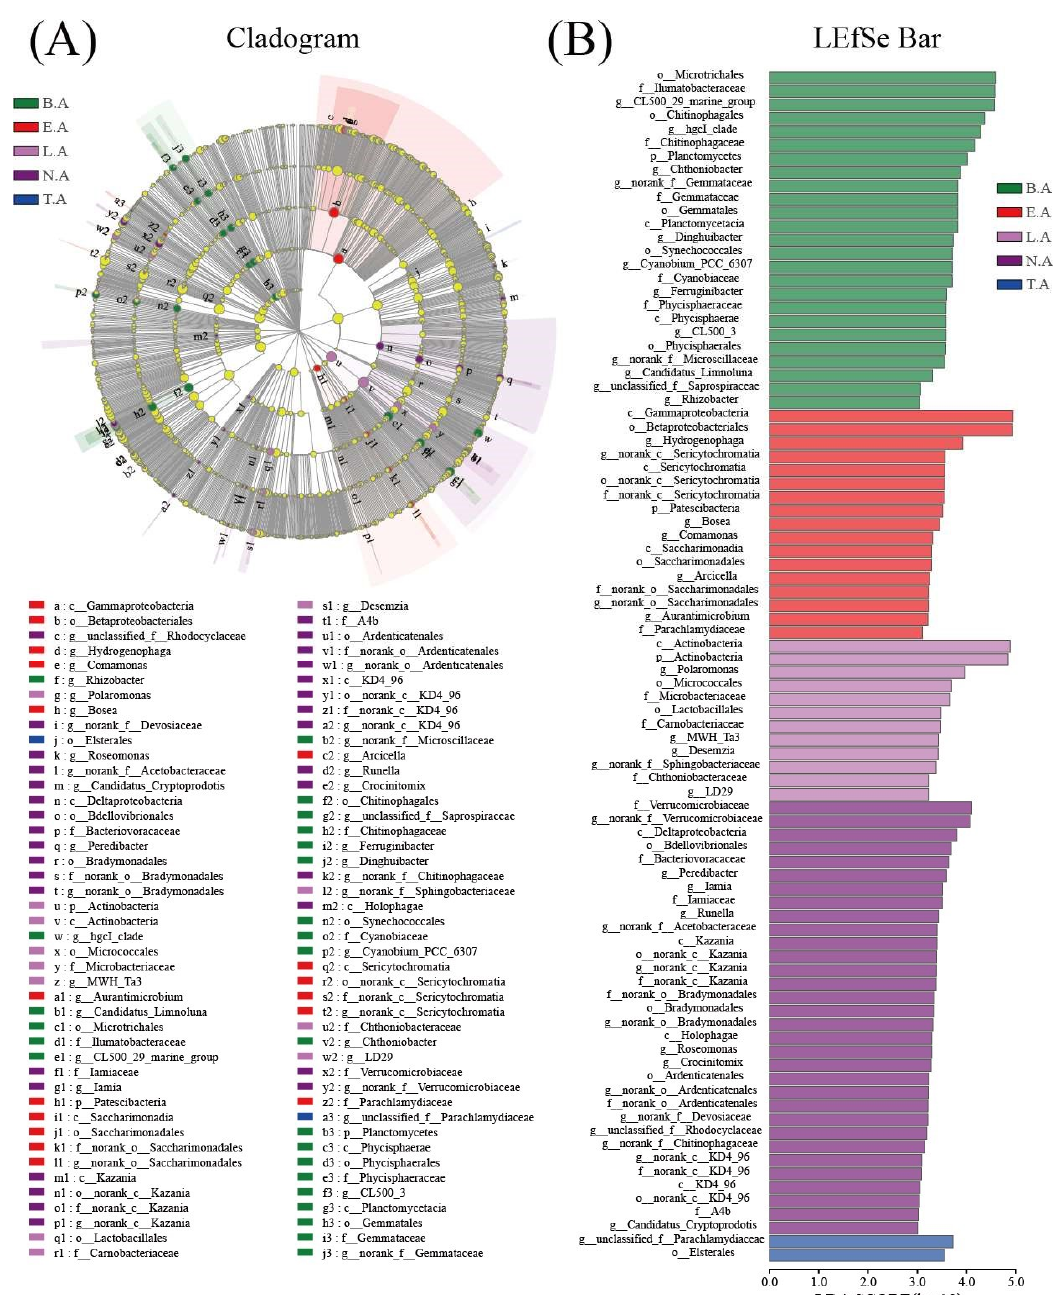
Figure 3. LEfSe analysis of microbial community in Baiyangdian Lake. ( A ) Cladogram; ( B ) LEfSe Bar.